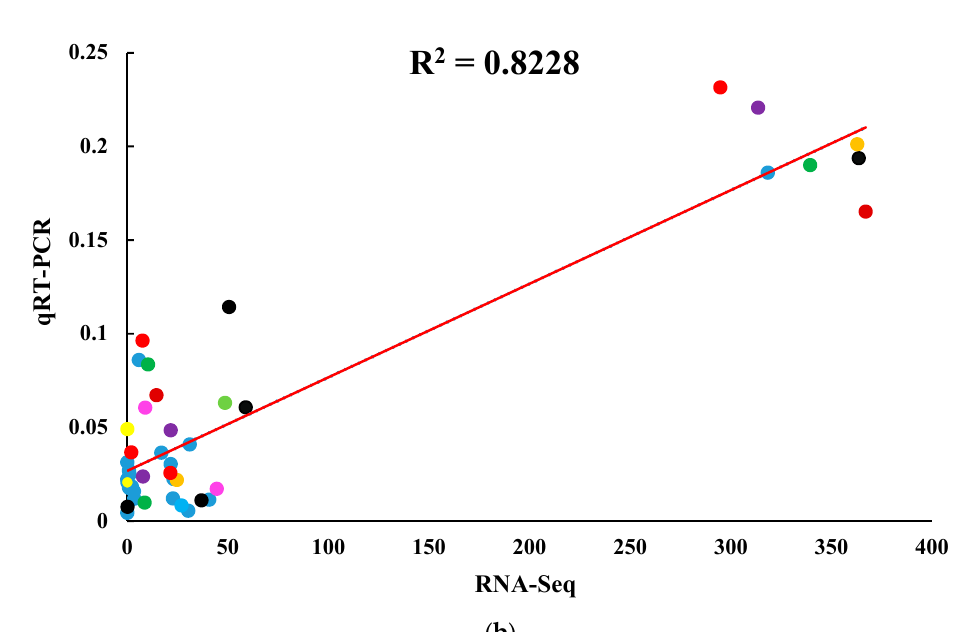
Figure 9. Heat map of DEGs involved in the monoterpene synthesis pathway ( a ) and correlation of FPKM analyzed by RNA-Seq (x axis) and the data obtained using qRT-PCR (y axis) ( b ). Heat maps depict the normalized gene expression values, which represent the means ± SD of three biological replicates. Expression values are presented as FPKM normalized counts. G3P, glyceraldehyde 3-phosphate; DXS, 1-deoxy-D-xylulose-5-phosphate synthase; DXR, 1-deoxy-D-xylulose 5-phosphate reductoisomerase; MEP, 2-C-methyl-D-erythritol 4-phosphate; HMBPP, (E)-4-hydroxy-3-methyl-but-2-enyl pyrophosphate; HDR, 1-hydroxy-2-methyl-2-(E)-butenyl-4-diphosphate reductase; IPP, isopentenyl pyrophosphate; DMAPP, dimethylallyl pyrophosphate; IPPI, IPP-isomerase; GGPPS, geranyl pyrophosphate synthase; GPP, geranylpyrophosphate; AACT, acetoacetyl-CoA thiolase; HMGS, 3-hydroxy-3-methylglutaryl synthase; HMG-CoA, 3-hydroxy-3-methylglutaryl-CoA; HMGR, 3-hydroxy-3-methylglutaryl-CoA reductase; MVA, mevalonate; MK, MVA kinase; MVP, mevalonate-5-phosphate; PMK, phospho-MVA kinase; MVPP, mevalonate-5-diphosphate; MPDC, diphospho-MVA decarboxylase; MVPP, mevalonate-5-pyrophosphate. Three genes were selected for the quantitative RT-qPCR experiments, including DXS, HMGR, and GPPS.